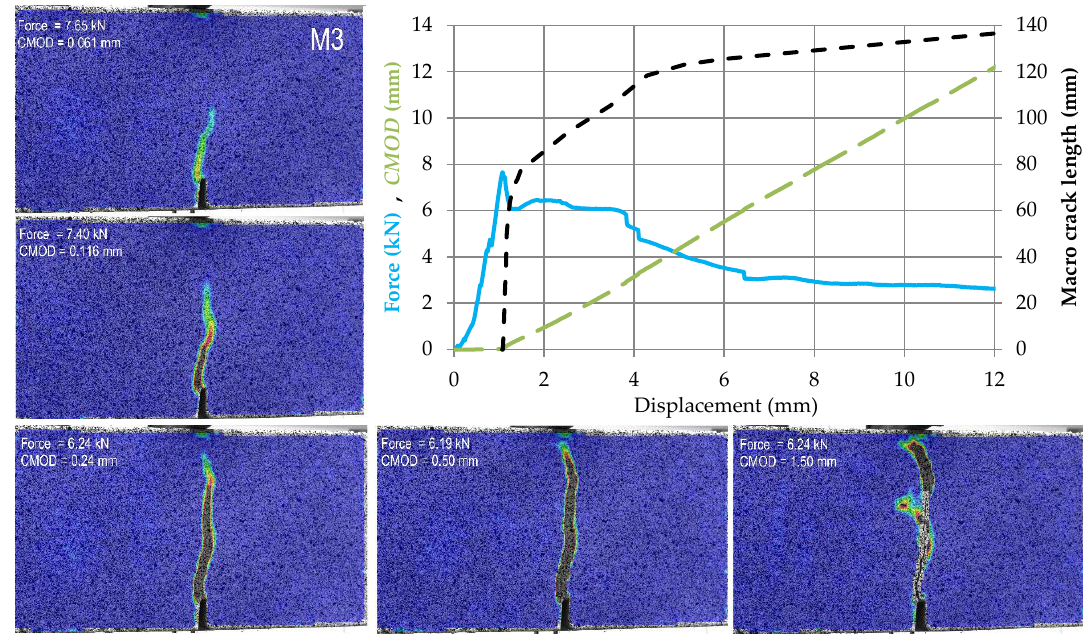
Figure 12. Force, CMOD and summary macrocrack length as a function of displacement in case of material M3 accompanied by cracks development in five chosen stages (contour plots of equivalent Huber–Mises strains).